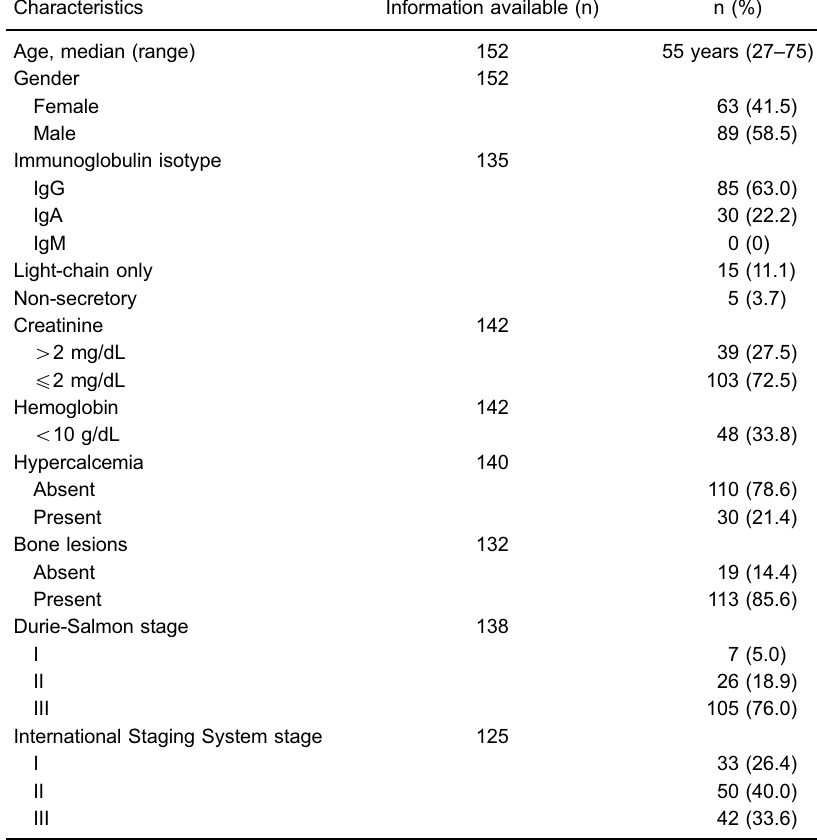
Table 1. Patients ’ characteristics